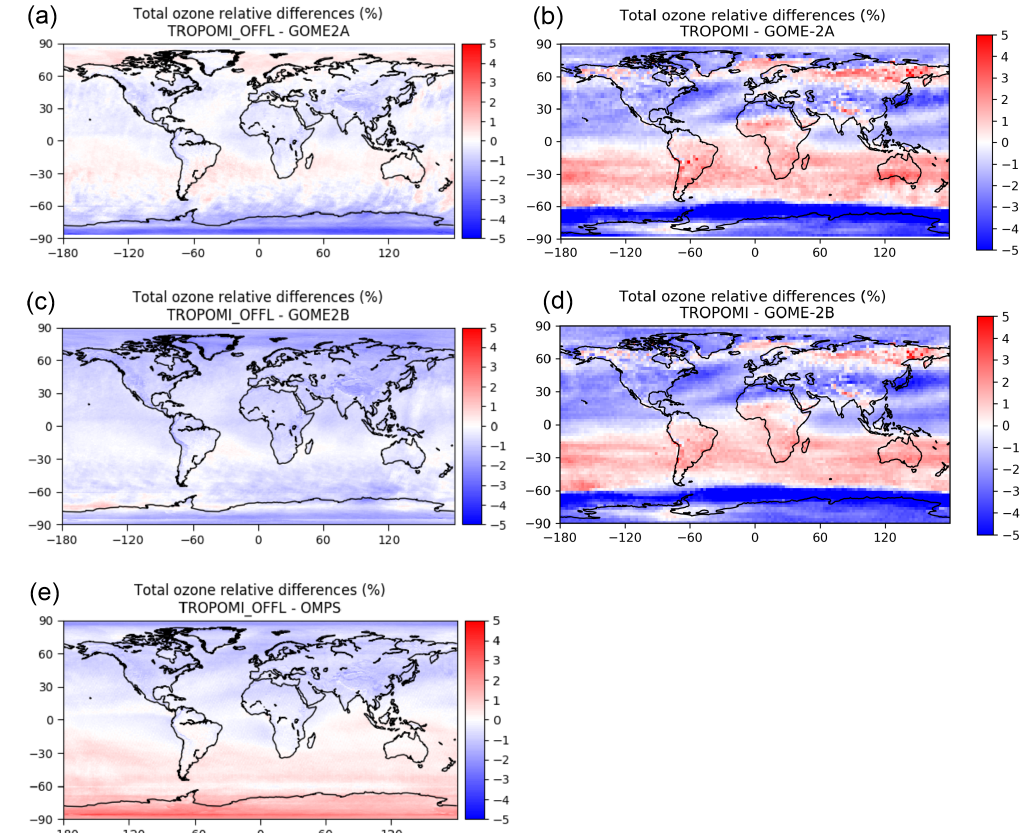
Figure 16. Global maps of relative differences (in percentages) between TROPOMI OFFL TOC and GOME2A, GOME2B and OMPS processed with GODFIT v4 (a, c, e) . The respective relative percentage differences of the TROPOMI NRTI TOC product compared to GOME2A and GOME2B, processed with GDP 4.8, are shown in (b, d)